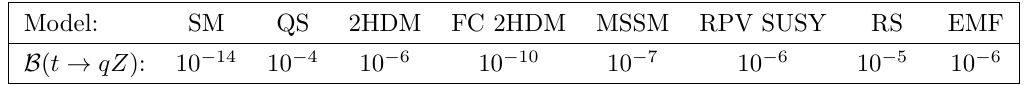
Table 1 . Maximum allowed FCNC t ! qZ ( q = u; c ) branching ratios predicted by several models